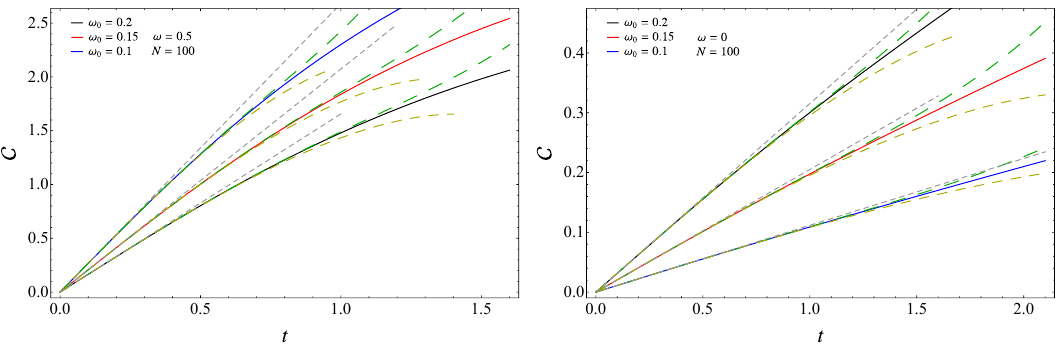
Figure 5 . Initial growth of the complexity for harmonic chains with PBC and N = 100 . The evolution Hamiltonian is either massive (left panel) or massless (right panel), for three values ω 0 . The solid lines show the complexity (3.7) (with (3.4)) and the dashed lines represent its expansion (2.36) up to the O ( t ) (grey), O ( t 3 ) (yellow) and O ( t 5 ) (green) term